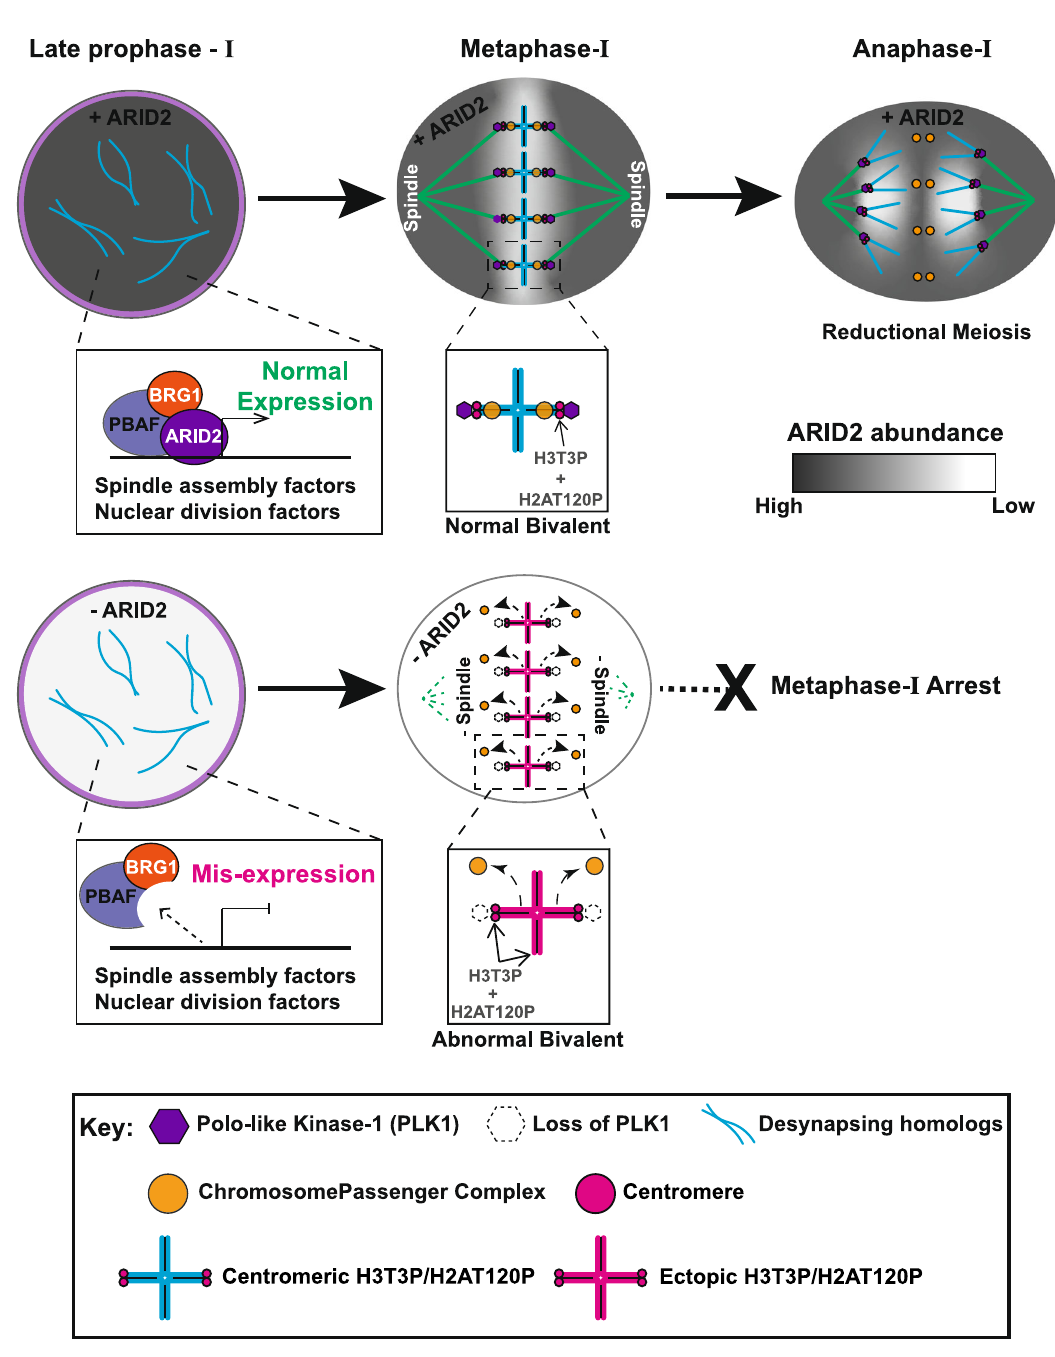
Fig. 9 Model describing the role of PBAF in spermatocyte cell division. ARID2 expression peaks towards the end of prophase-I (diplonema), when the PBAF complex is associated with centromeres and promoters of genes known to participate in processes such as spindle assembly and nuclear division. The timely regulation of these genes is critical for the transition from metaphase-I to anaphase-I, culminating in reductional meiosis. Metaphase-I spermatocytes expressing ARID2 assemble bipolar spindle attached to meiotic bivalents (shaded blue) that display kinetochores enriched for PLK1 (purple hexagon), centromeric H3T3P/H2AT120P (magenta circle), and chromatin-associated chromosome passenger complex (CPC) (Orange circle). The loss of ARID2 results in a metaphase-I arrest due to the mis-expression of essential cell division genes. Consequently, mutants lack normal spindle and display abnormal meiotic bivalents (shaded magenta) with kinetochores devoid of PLK1 (empty hexagon), ectopic H3T3P/H2AT120P distributed chromosomally, and chromatin de fi cient in